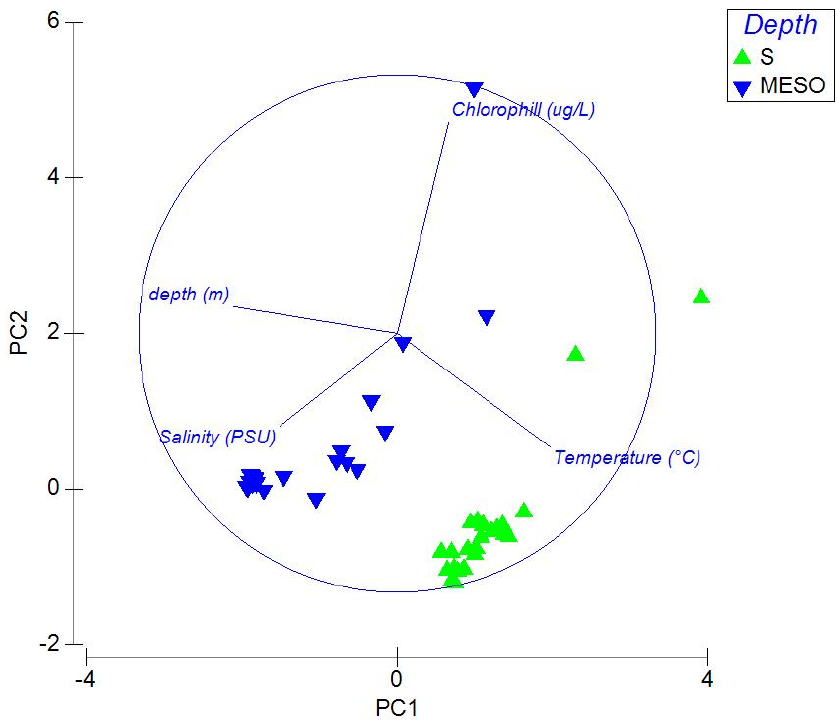
Figure 4. Principal Component Analysis (PCA) on abiotic data and Figure 4 . Principal Component Analysis (PCA) on abiotic data and taxa.